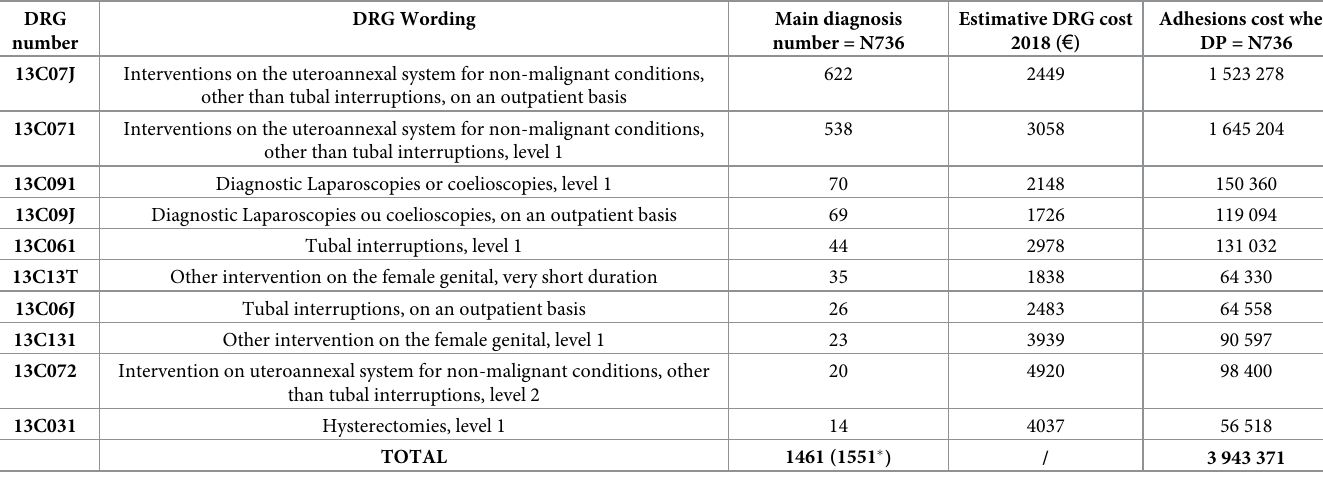
Table 4. Direct cost evaluation for reoperations related to